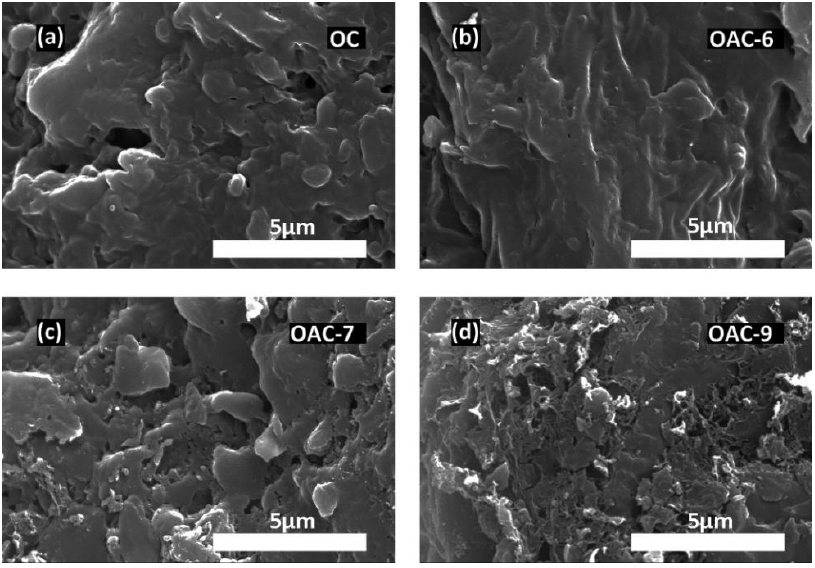
Figure 1. SEM images of ( a ) OC, ( b ) OAC-6, ( c ) OAC-7, and ( d ) OAC-9. The crystal types of OC, OAC − 6, OAC − 7, and OAC − 9 were tested by XRD. It can be seen in Figure 2 that the XRD patterns of the four materials are seriously broadened, indicating that all the samples have poor crystallinity and are primarily amorphous. The two broad peaks at 26° and 44° correspond to the (002) and (100) characteristic crystal planes of graphite, respectively, indicating that the four materials have been initially graphitized. The diffraction peak intensity of OAC − 6, OAC − 7, and OAC − 9 is significantly stronger than that of OC, indicating that the higher temperature carbonization treatment can improve the graphitization degree of samples.